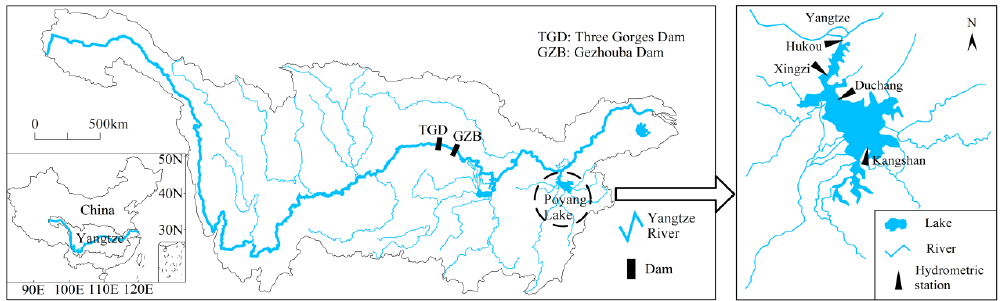
Figure 1. Sketch of Poyang Lake and locations of hydrometric stations.